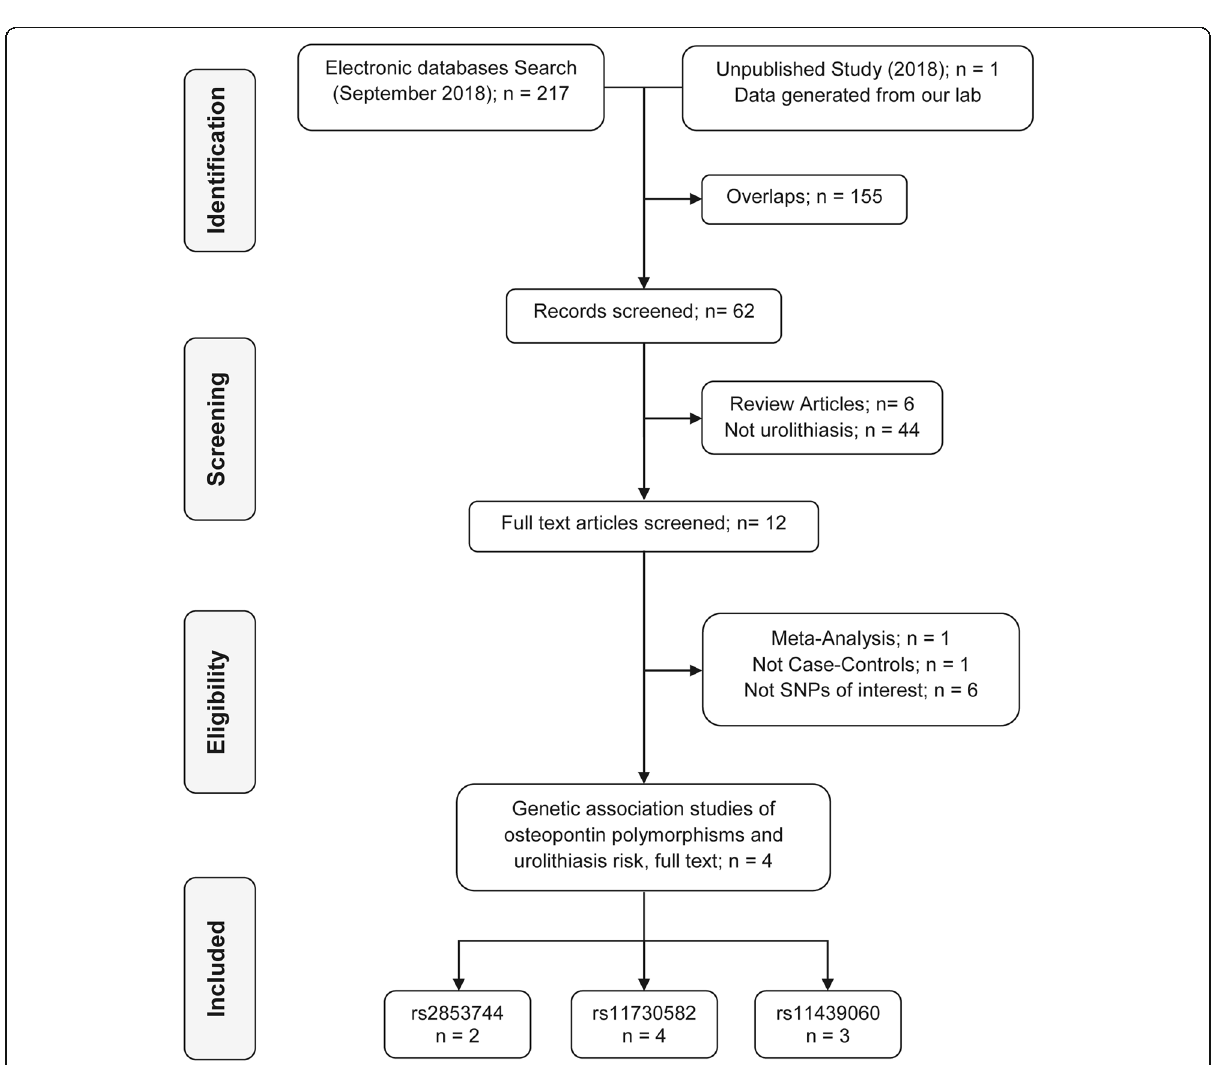
Fig. 1 Flow diagram reflecting selection process of eligible studies included in meta-analysis. Initial literature search identified a total of 217 records from different online databases including Google Scholar, PubMed, ScienceDirect, Cochrane library and Embase. Of these, 155 overlapping studies (same studies that were indexed in two or more of these databases and resulted in redundant entries) were excluded, retaining 62 unique studies for further screening. Subsequent screening according to defined eligibility criteria yielded a total of 04 final studies including in this